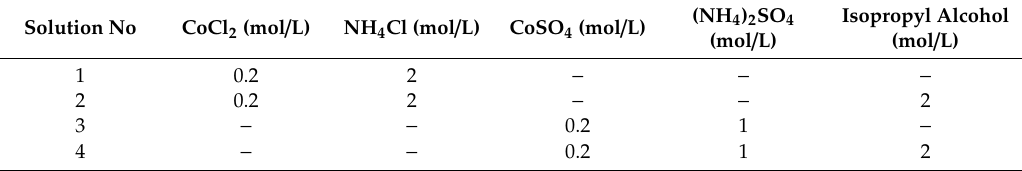
Table 1. The chemical compositions of solutions used for deposition of cobalt foams; pH